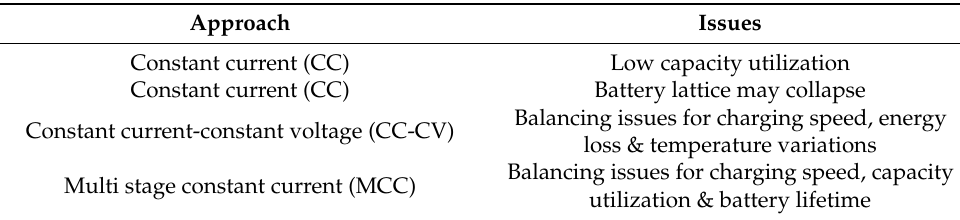
Table 5. Comparison of charging methods